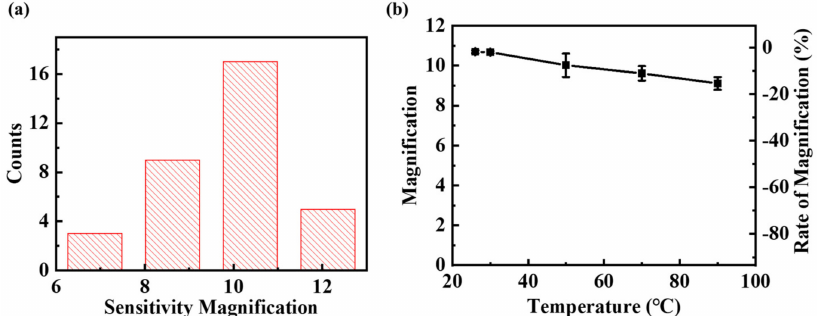
Figure 6. ( a ) The statistical result of the sensitivity magnification for sensors with and without the double-gap MFC, and ( b ) the sensitivity magnification versus temperature within the range of room temperature (26 ◦ C) to 90 ◦